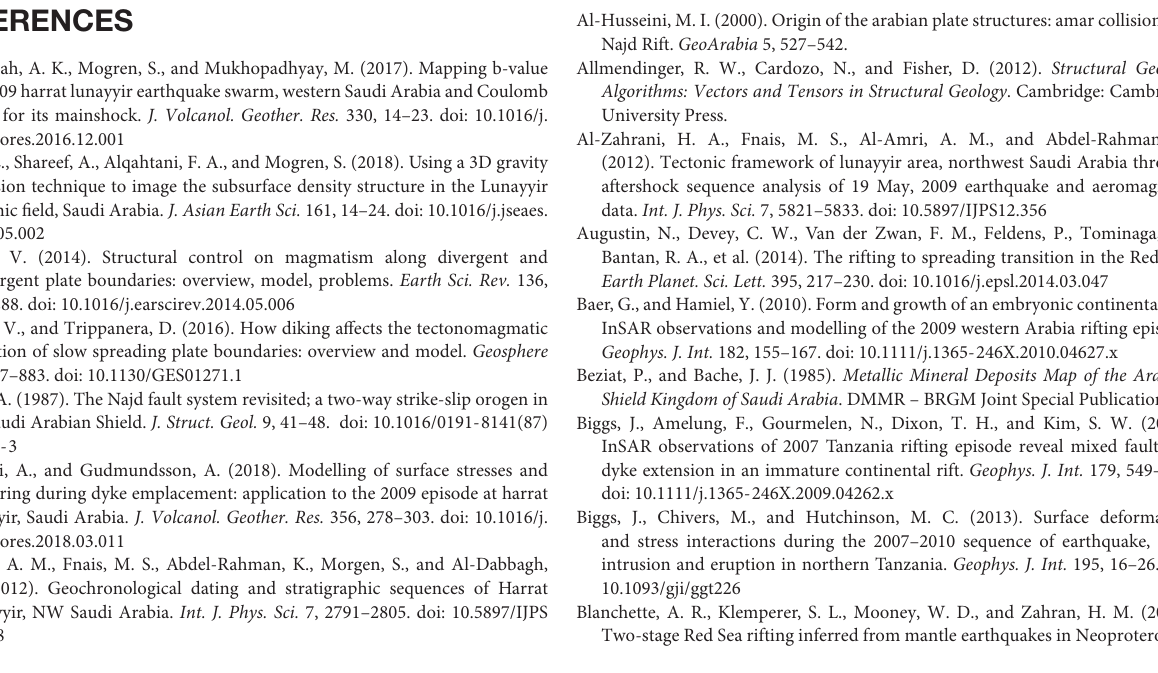
FIGURE S1 | Maps of a selected portion of segment G along the western fault showing the DEM, the ortho-photo blended with hillshade information, terrain roughness and slope. The stereonet shows pole density (with 1% area method: %value = n (100)/N where n is the number of points falling in an area of the plot and N is the total number of points) of faults and open fractures measured in the field at this location. The black dot is the 2009 dike pole. The stereonet plot was generated using the Stereonet software by Allmendinger et al. (2012) and Cardozo and Allmendinger (2013). FIGURE S2 | Evolution of deformation patterns induced by an arc-shaped analog dike (modified from Xu et al., 2016). The extent of dike opening increases from (a) 0.32 cm to (f) 0.6 cm. See Xu et al. (2016) and the dataset by Corbi et al. (2019) for further details. FIGURE S3 | The drone ortho-photo of the surveyed area along the western fault after blending it with hillshade information using the QGis software. Refer to the Pix4d software report for further details on the western fault data processing. FIGURE S4 | The drone ortho-photo of the surveyed area in the eastern fracture zone after blending it with hillshade information using the QGis software. FIGURE S5 | Map of sampled areas used to calculate the roughness and the topography standard deviation for different lithotypes (see also Figures 8C,D ). Numbers identify each area. See Supplementary Table S1 for more details. TABLE S1 | Mean, median and standard deviation (STD) of roughness and elevation for each area of Supplementary Figure S5